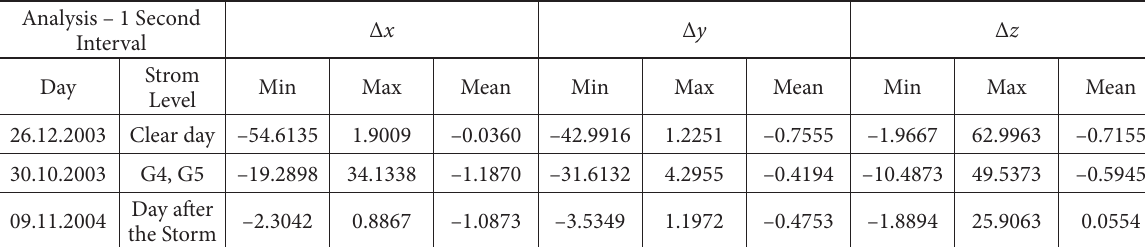
Table 7. Overview of days analyzed at 1 second interval Analysis – 1 Second